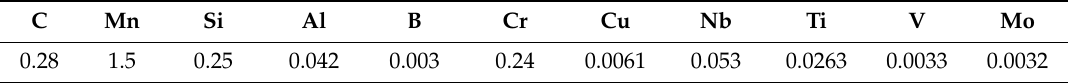
Table 2. The composition of ultra-high strength hot-stamping